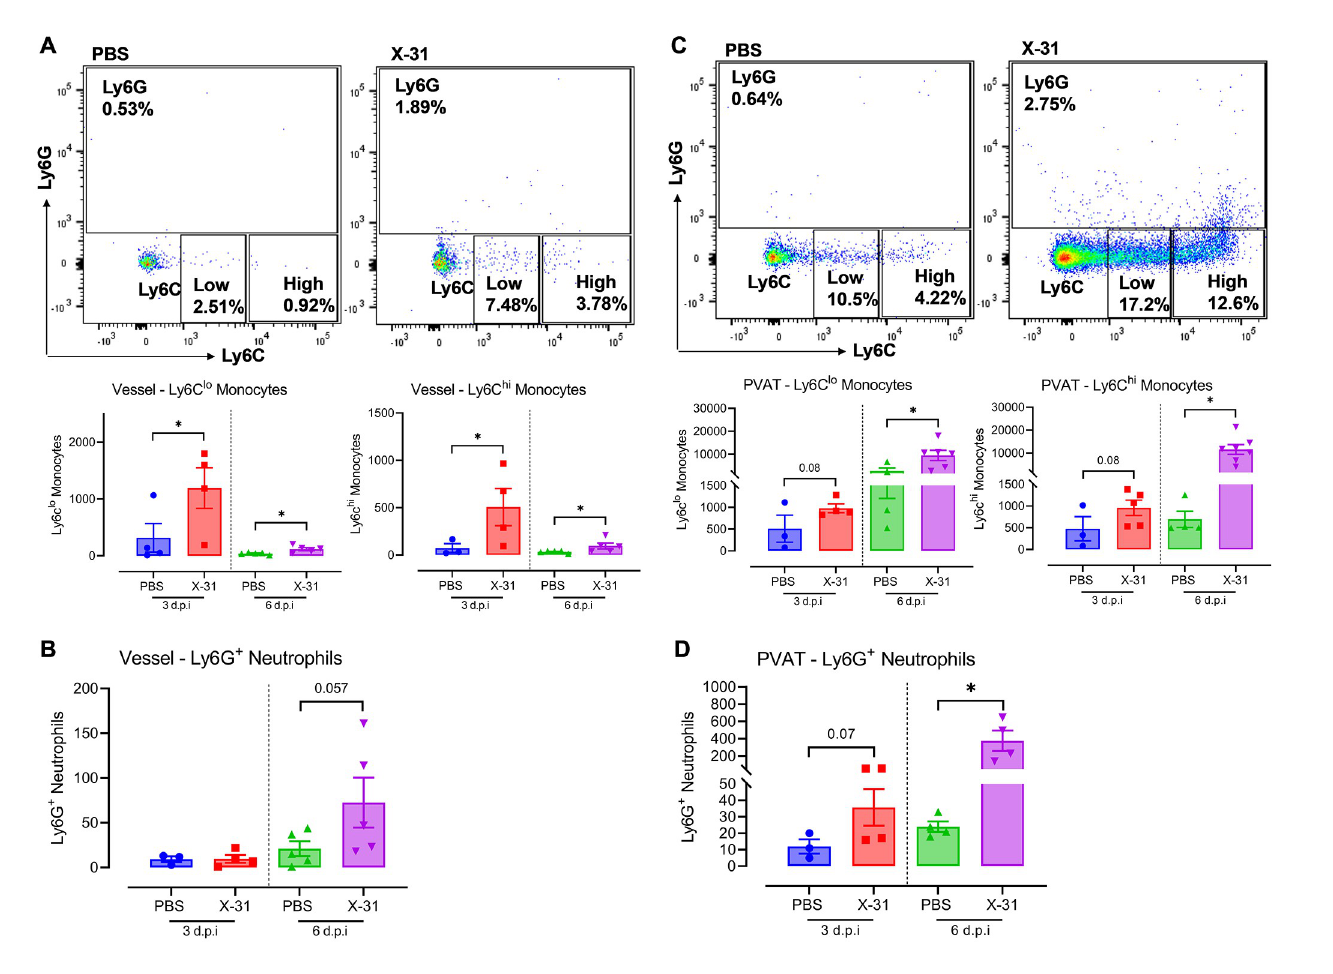
Fig 4. IAV promotes innate inflammation via substantial infiltration of monocytes and neutrophils in PVAT compared to arterial wall in pregnant mice. Separate single cell suspensions were prepared from vessel wall and PVAT digests from pregnant mice that were inoculated with either PBS or Hk-x31 virus (X-31; 10 4 PFU) at 3 and 6 d.p.i and quantified via flow cytometry for the following cell subsets. (A) Representative dot plots and quantification showing patrolling monocytes (CD11b + Ly6C low ) and pro-inflammatory monocytes (CD11b + Ly6C high ) in the vessel wall. (B) Ly6G + neutrophils quantification. Quantification results in the vessel wall are also shown. (C) Representative dot plots and quantification showing patrolling monocytes (CD11b + Ly6C low ) and pro-inflammatory monocytes (CD11b + Ly6C high ) in the PVAT. (D) Ly6G + neutrophils quantification. Quantification results in the PVAT are also shown. All cell populations were measured as absolute number of CD45 + population per 25,000 counting beads. Data are represented as mean ± SEM (pregnant PBS, n = 4–6; pregnant X-31, n = 4–6; of at least two independent experiments). Statistical analysis was performed using unpaired t-test against their respective PBS control. � P < 0.05.